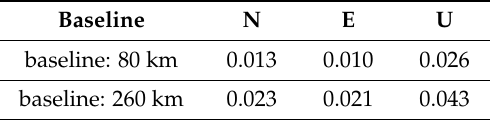
Table 4. Positioning Precision of the North, East and Up Direction